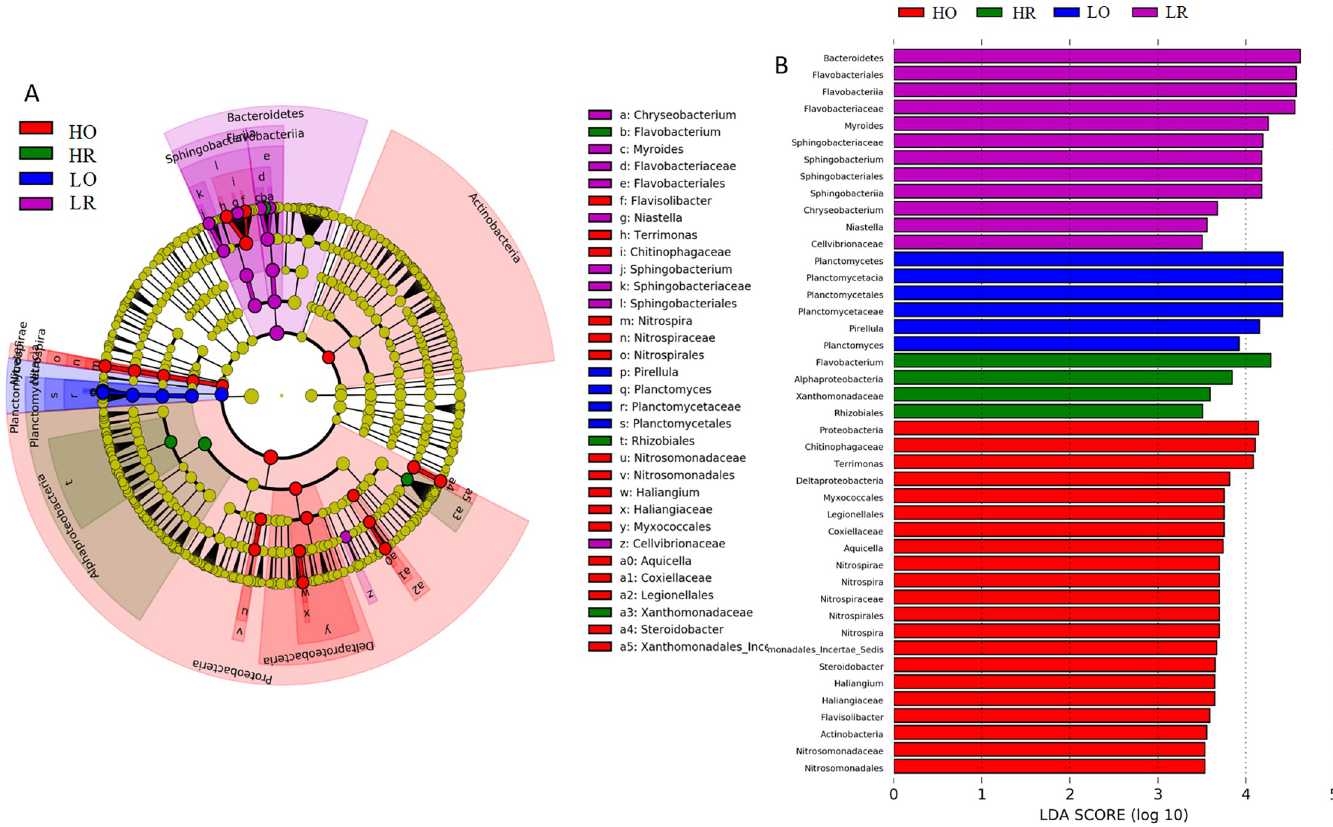
Fig 5. Distribution and representation of the taxa contributing to the different microbial communities in four soil samples. A. LEfSe taxonomic cladograms. Significantly discriminant taxon nodes are coloured. Branches are shaded according to the highest ranked group for the corresponding taxon. The yellow nodes represent the taxa with no significant differences among the sampled habitats. B. Histogram of LDA scores showing the discriminant taxa among four soil samples.